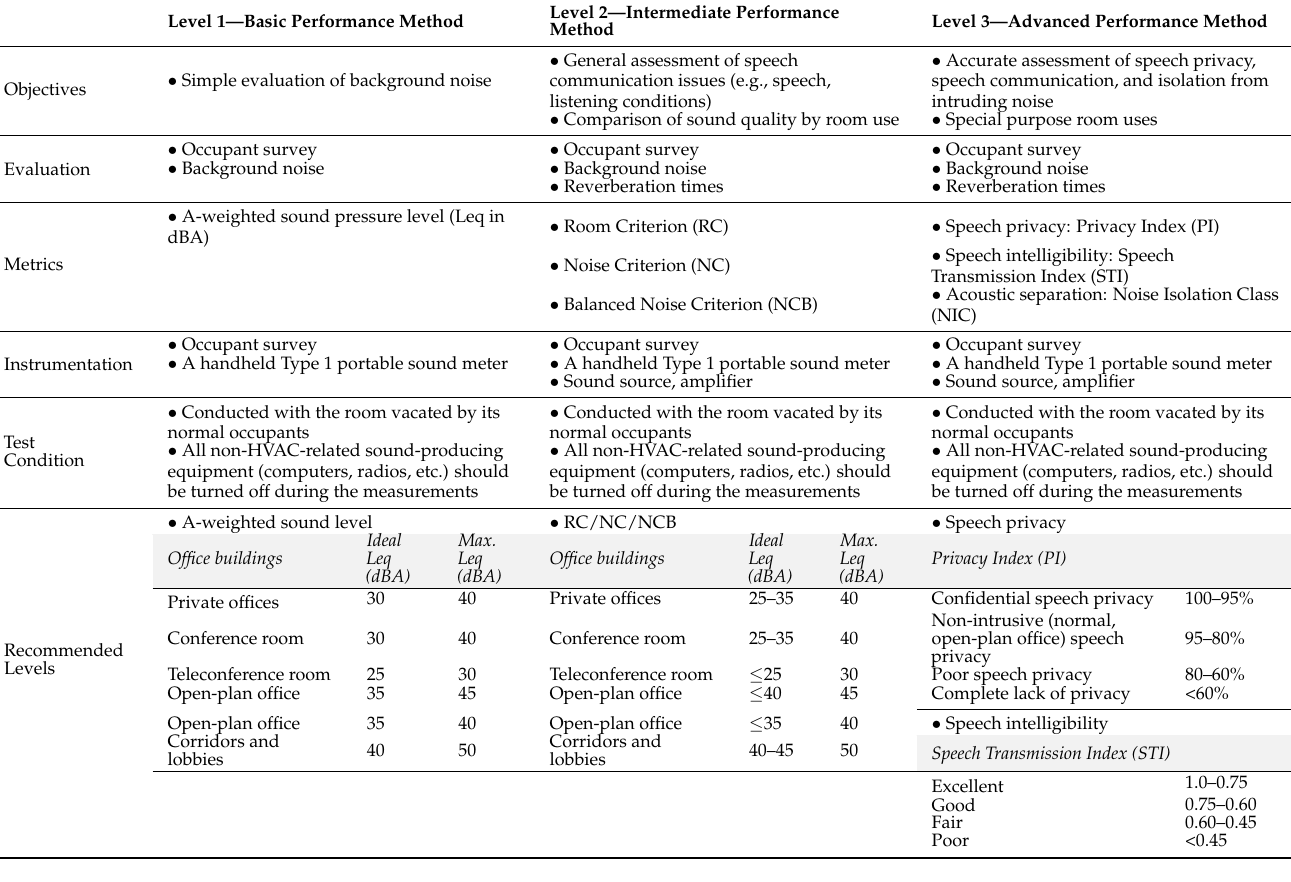
Table 3. Performance Measurement Protocols for Commercial Buildings by ASHRAE 2010.